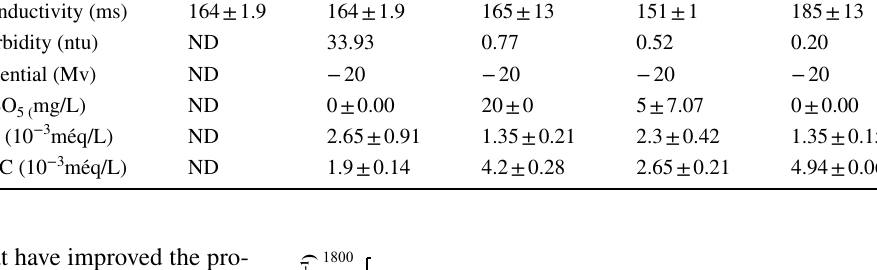
petroleum dispersion on the physicochemical properties of seawater